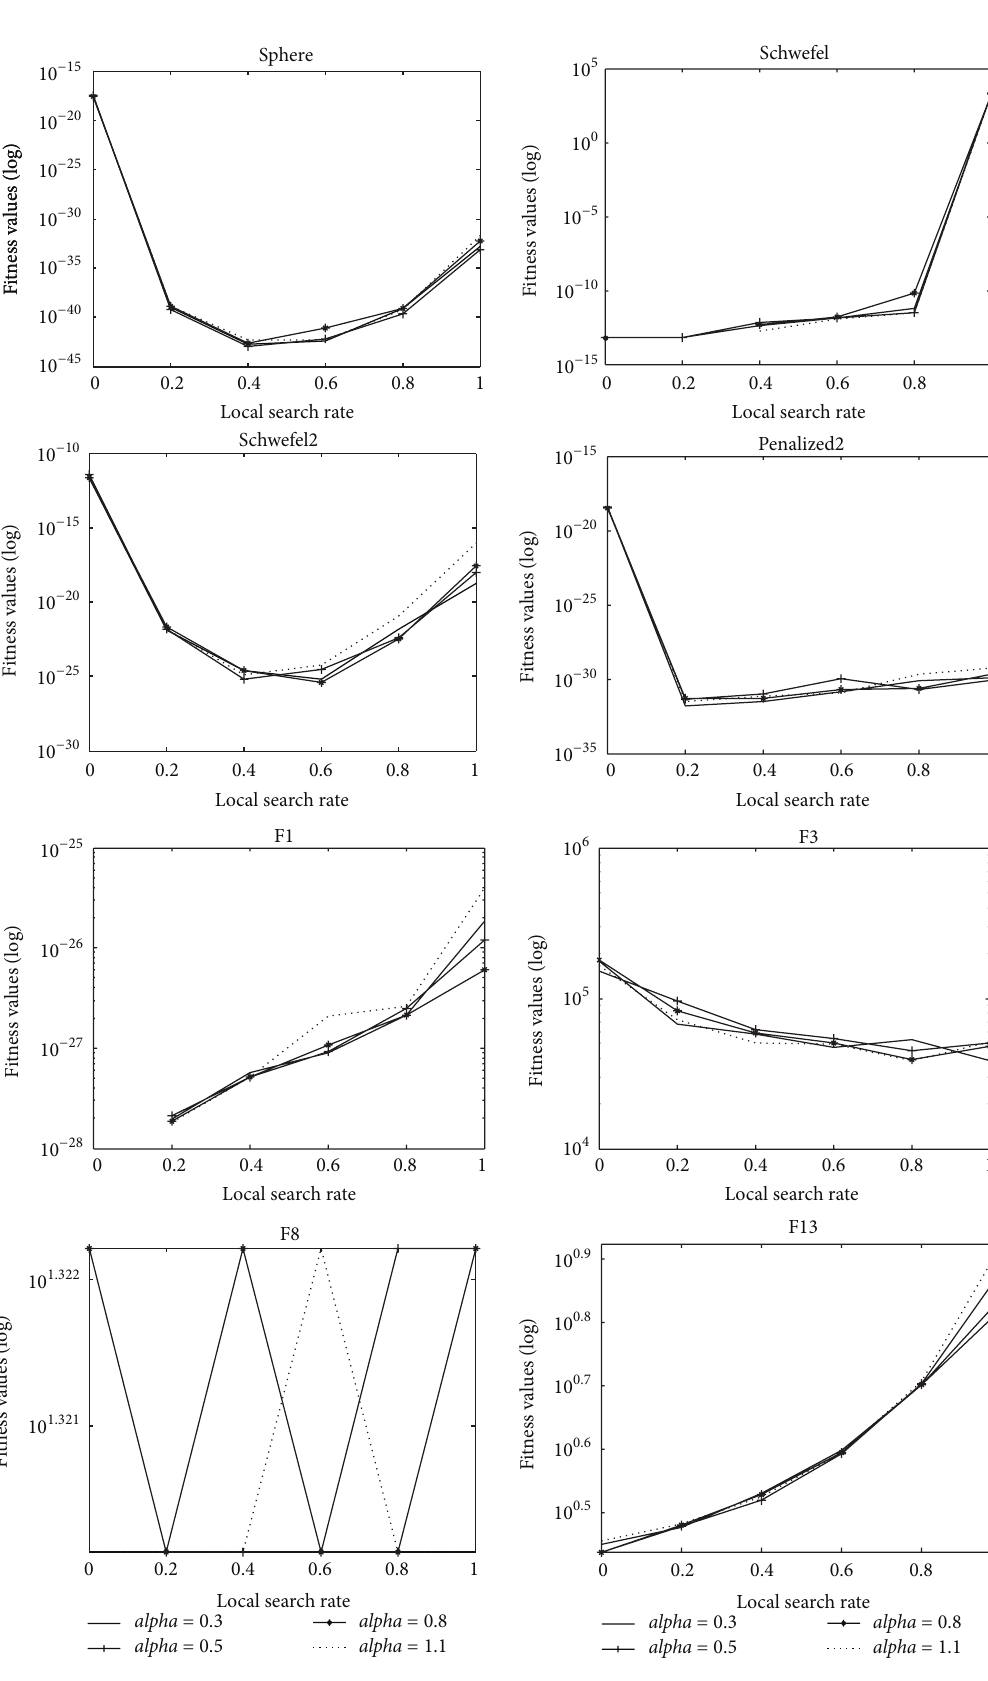
Figure 1: Results of MLBBO on eight test functions with different alpha and 𝑝 𝑙